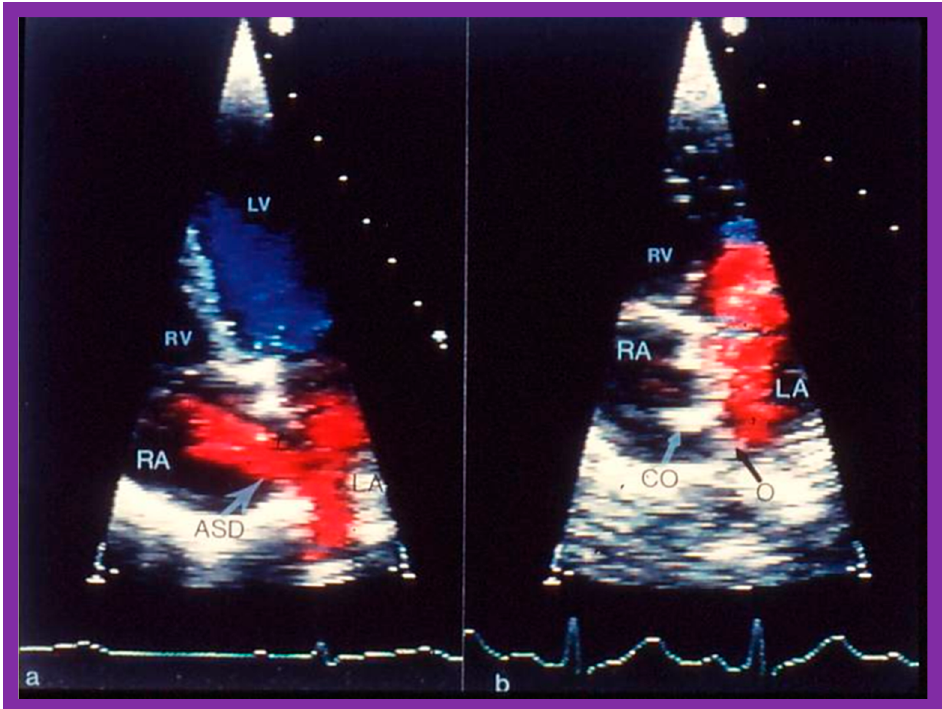
Figure 43. Echocardiographic images from subcostal long ( A , B ) and short ( C , D ) -axis transthoracic study of the atrial septum, illustrating Amplatzer Septal Occluder (ASO) closing an atrial defect three years after the device implantation; note good position of the ASO device ( A – D ) without re- sidual shunt ( B , D ). Left atrium (LA), right atrium (RA), and superior vena cava (SVC) are labeled.